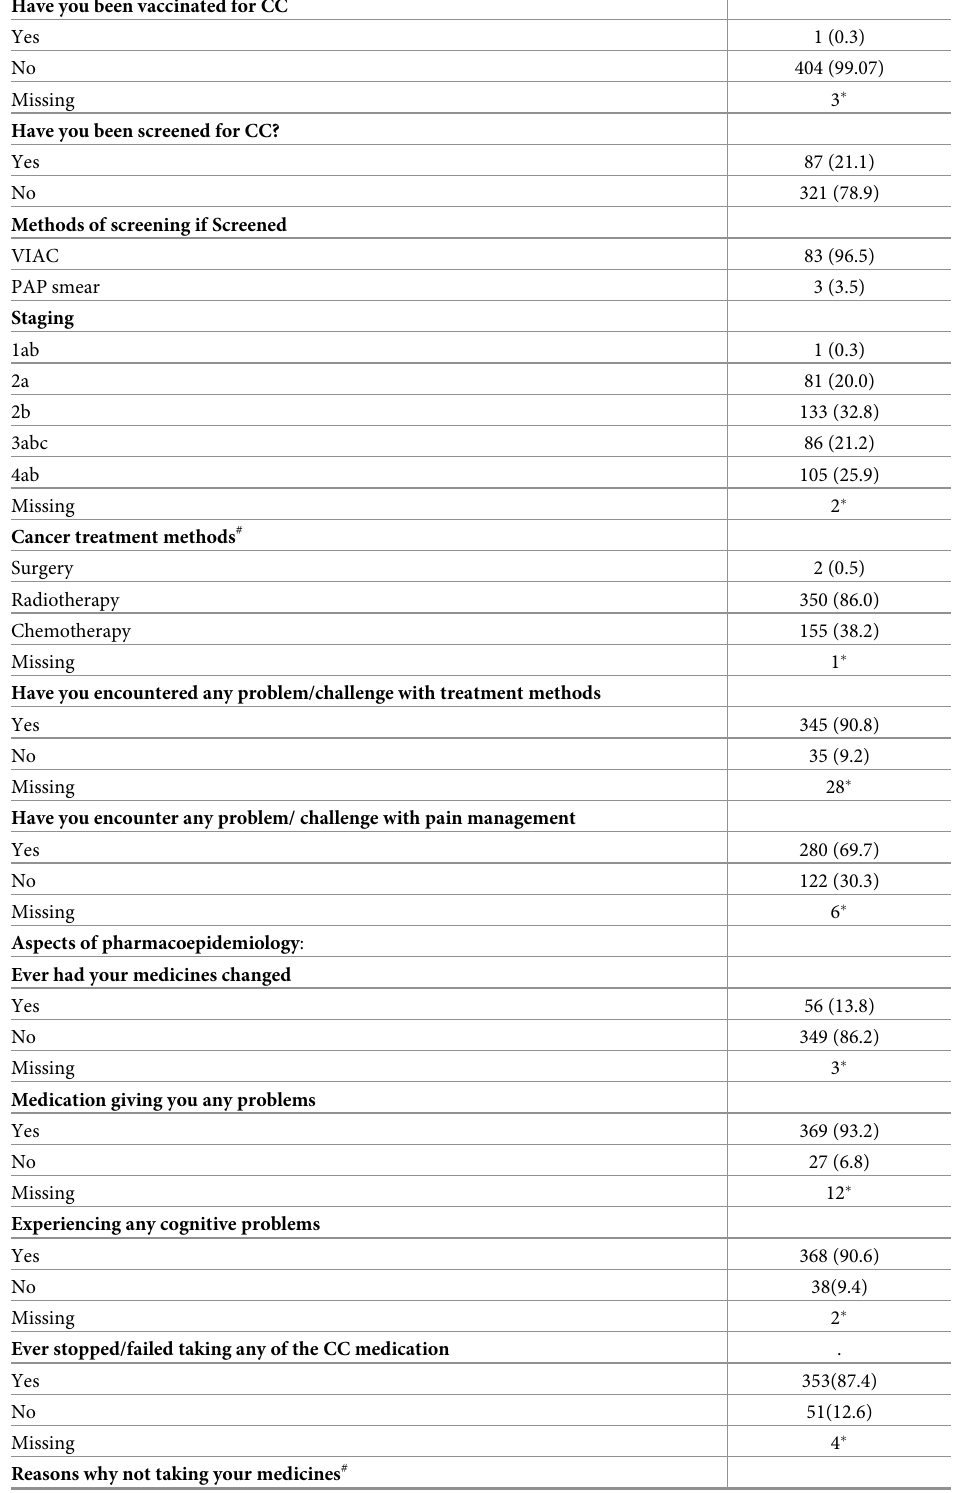
Table 2. CC management related characteristics (N =